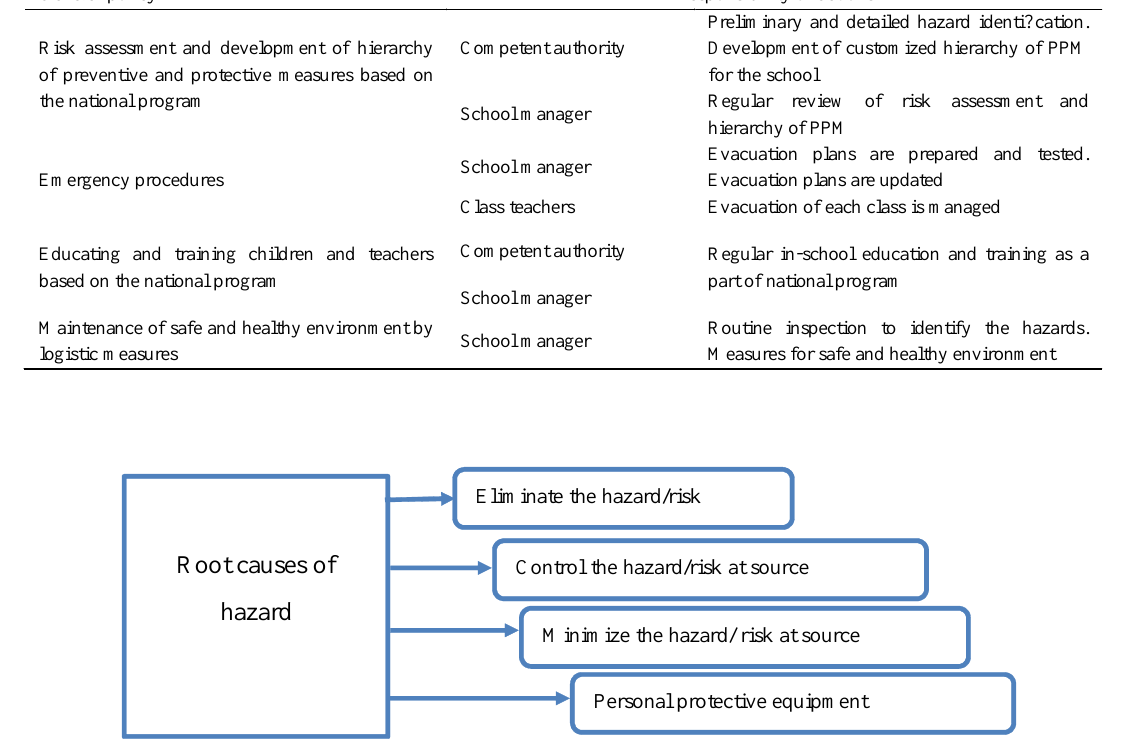
Table 1: An example of CSH policy for a school (adapted from Health and safety executive, 2013) General policy